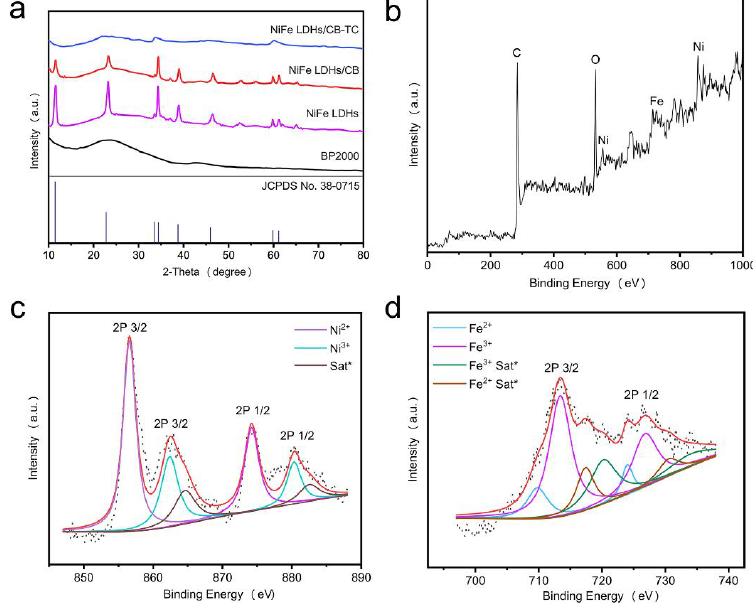
Figure 5. ( a ) XRD patterns of all samples; ( b ) XPS survey, ( c ) Ni 2p, ( d ) Fe 2p spectrum of NiFe LDHs/CB-TC.